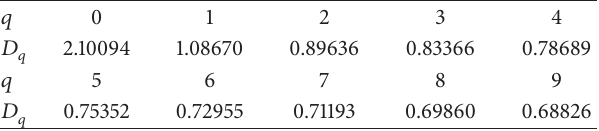
Table 8: The generalized dimension value of inner ring fault signal.